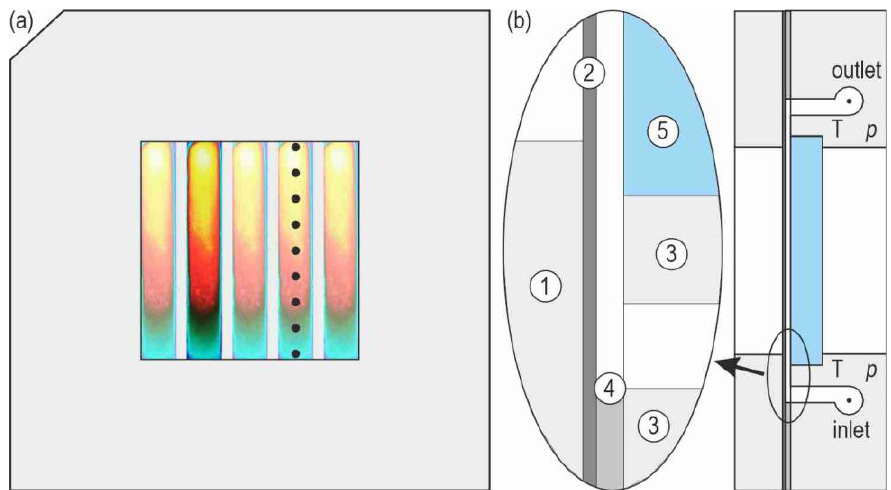
Figure 2. The test section with mini-channels: ( a ) view on the side of the front cover, ( b ) cross section along the mini-channels, (1) front cover, (2) heated foil, (3) body, (4) spacer with mini-channels, (5) glass plate, T-thermocouple, p – pressure measurement.